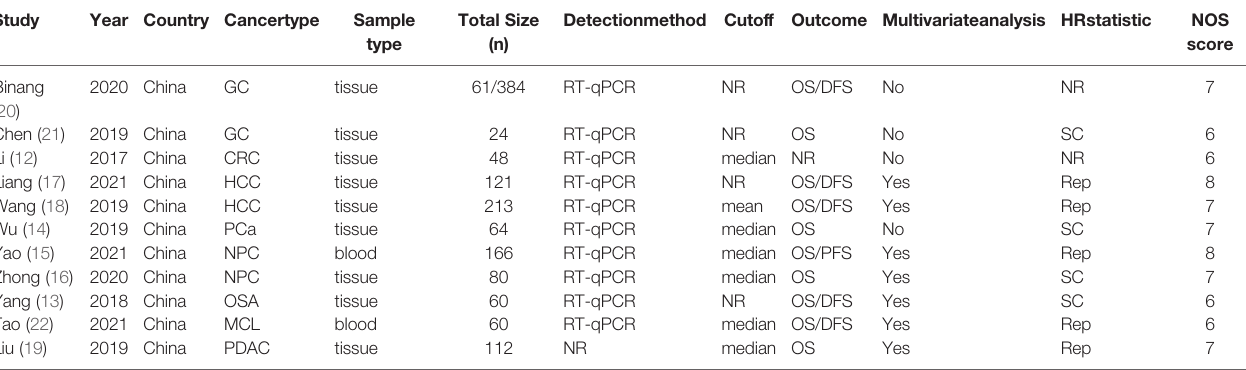
TABLE 1 | Characteristics of studies in this